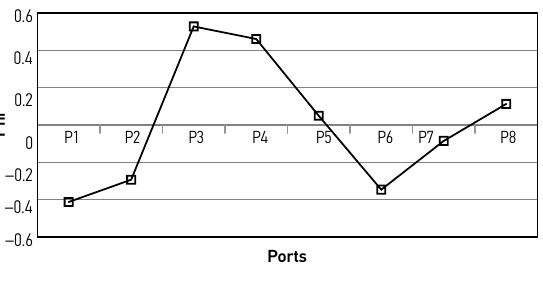
Fig. 2. The ports positions corresponding to the PROMETHEE net flows determined according to the A2 set sub-criteria values